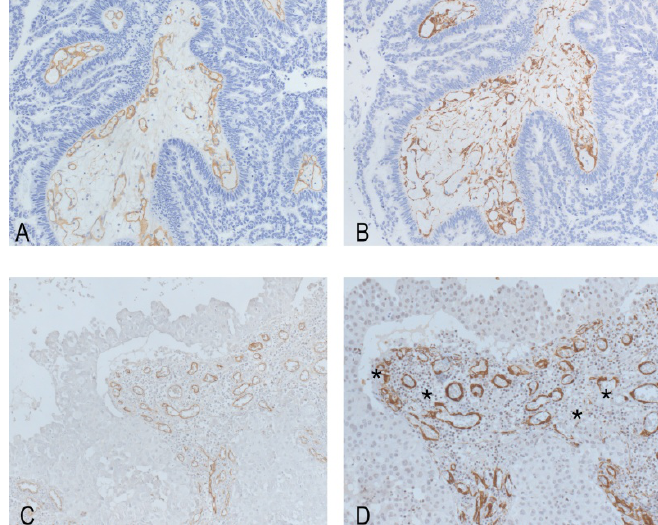
Figure 3. Endoglin-stained vessels in a case of BM from serous papillary ovarian carcinoma ( A ) (endoglin stain; original magnification; ×200) and in a BM from lung adenocarcinoma ( C ) (endoglin stain; original magnification; ×200). A consecutive section showing that endoglin-positive vessels were also stained by anti-smooth muscle actin (SMA) antibody in BM from ovarian carcinoma ( B ) (endoglin stain; original magnification; ×200); while SMA stain was incomplete in some of the endoglin-positive vessels in BM from lung adenocarcinoma ( D ) (SMA stain; original magnification; ×200). The stars indicate vessels with incomplete pericyte